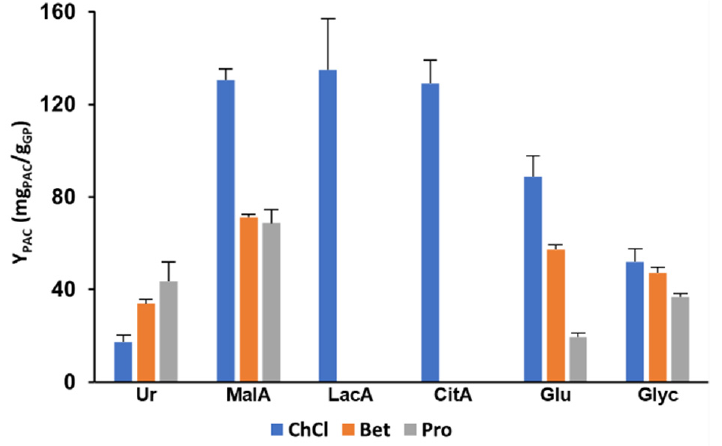
Figure 3. Extractability of PACs from GP with different ESs using MAE at 100 °C for 10 min. The best extractability results were obtained by combining MalA with ChCl (130.5 mg PAC /g GP ), doubling from what was obtained with Bet or Pro. When analyz- ing the effect of combining different organic acids with ChCl, namely, LacA and CitA, it becomes clear that for this system, no significant differences were observed with very similar values being obtained of 135.0 and 129.1 mg PAC /g GP , respectively. The use of ESs based on ChCl and organic acids, although not widely explored for the extraction of PACs, is frequently found to be the most effective combination when compared to others not containing organic acids for the extraction of phenolic compounds from biomass such as chlorogenic acid from Morus alba L. leaves using ChCl:CitA [21], anthocyanins, and catechin from grape skin using ChCl with oxalic acid [22] and pelargonidin-3-glucoside from strawberry extrudate using ChCl with glycolic and oxalic acids [23]. In the case of PACs, this may be explained by two factors, namely due to PAC depolymerization that reduces their affinity for the pectin and hemicellulose fractions of the cell wall [24] or by dissolving the hemicellulose or lignin components of the cell wall contributing to the PAC release into solution